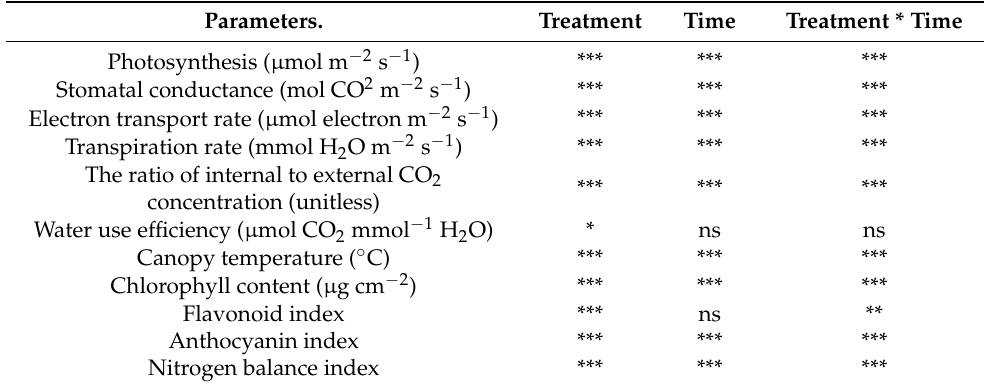
Table 1. Analysis of variation across the waterlogging treatment, the time during waterlogging treat- ment, and the interaction between treatment and time for soybean physiological traits at the repro- ductive stage.